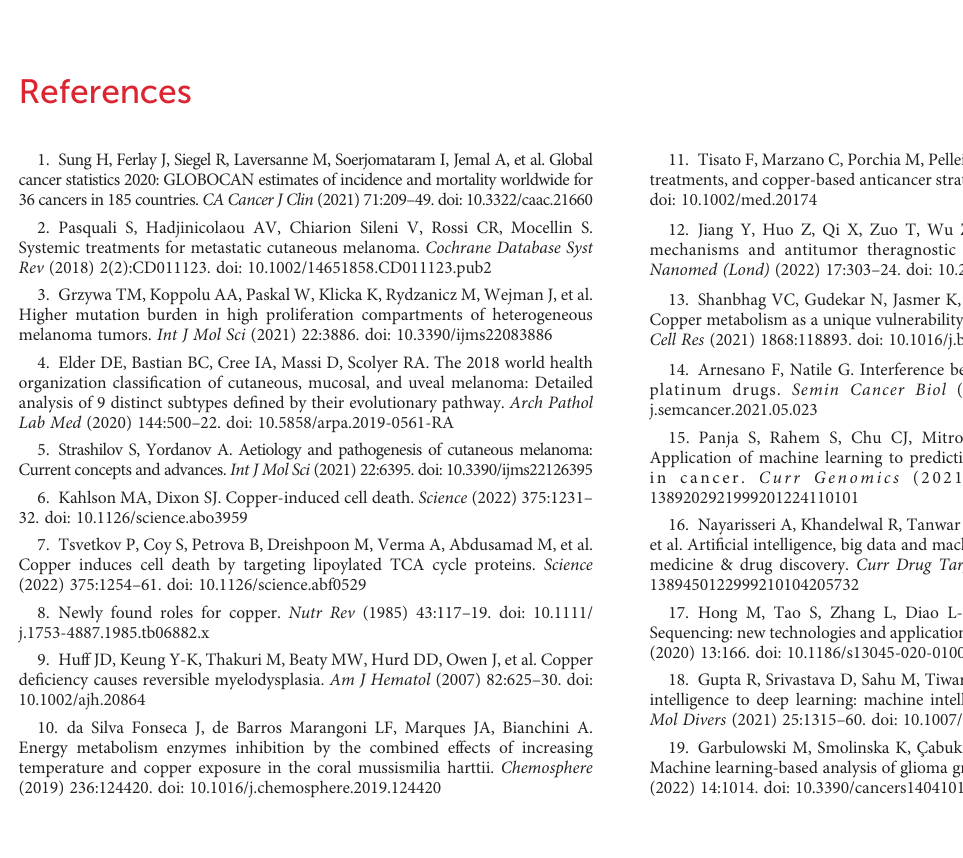
three gene subtypes. (F) Heatmap showing clinical information and gene expression pro fi les for the